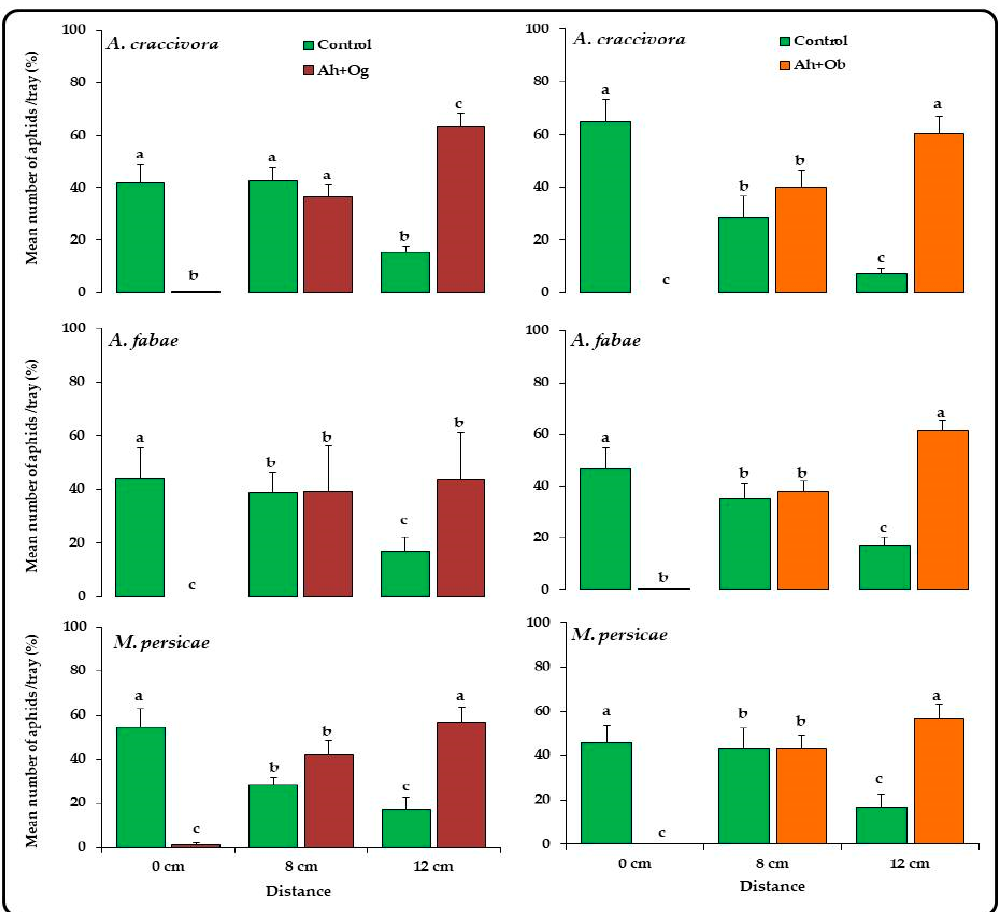
Figure 2. Aphid number (Mean ± SE, six replicates) on the central plant (0 cm) and selected plants (8 and 12 cm) according to the tested treatments, twelve days after aphid release. Control: A. hybridus alone, Ah: A. hybridus , Og: O. gratissimum , Ob: O. basilicum. For each distance, the bars with the same letter do not differ significantly ( p > 0.05). Within each treatment (control, Ah + Og and Ah + Ob), the bars with the same letter do not differ significantly ( p > 0.05).